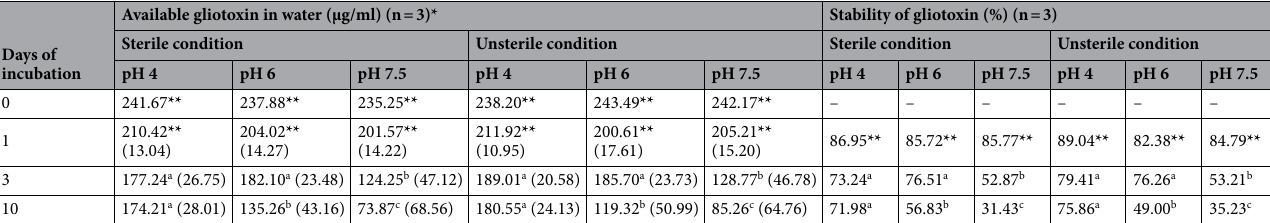
Table 2. Stability of gliotoxin in irrigation water. In each row, the mean values followed by a common letter or ** are not significantly different (p ≤ 0.05, DMRT analysis). Values in the parentheses are percent degradation of gliotoxin. *Values are means of three